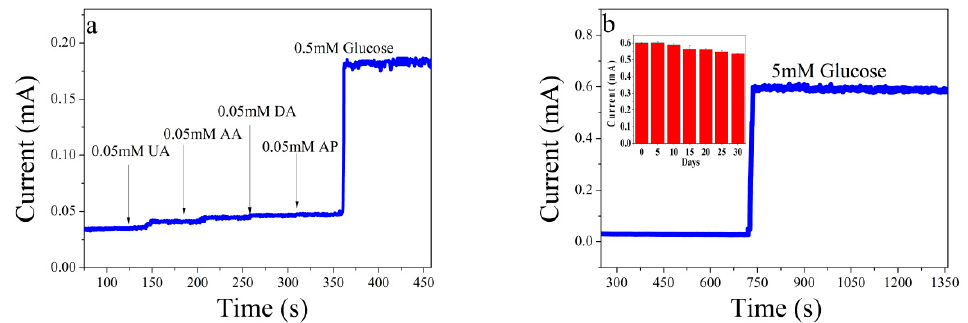
Figure 4. ( a ) Selectivity for glucose (0.5 mM) in presence of uric acid (0.05 mM), ascorbic acid (0.05 mM), dopamine (0.05 mM), and acetaminophen (0.05 mM), and ( b ) amperometric response of Au foam to 5 mM glucose in 0.3 M NaOH solution for running time of 10 min (inset: long-term stability of Au foam with 5 mM glucose for 30 days).